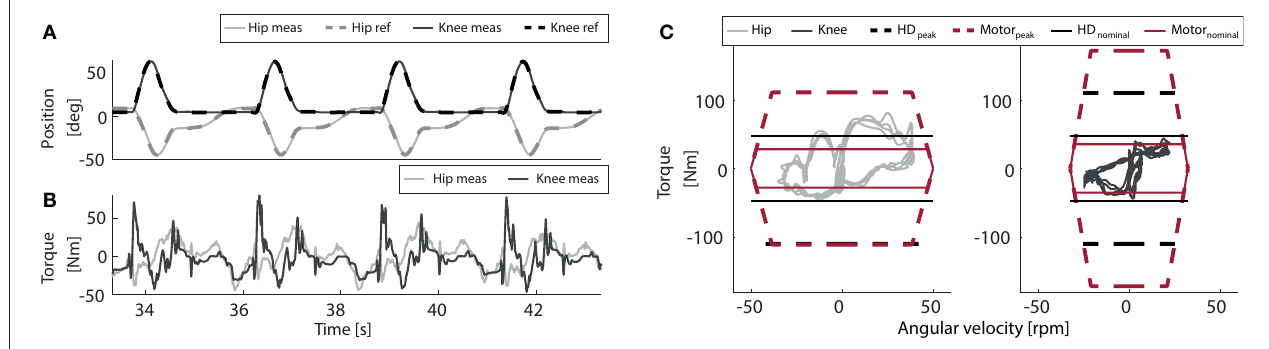
FIGURE 6 | Torque-velocity characteristic of the actuator modules of the hip and the knee joints, transposed for a 110kg patient weight. (A) Trajectory references and tracked positions. (B) Measured torques. (C) Torque/speed plots and mechatronic limits of the actuation system.